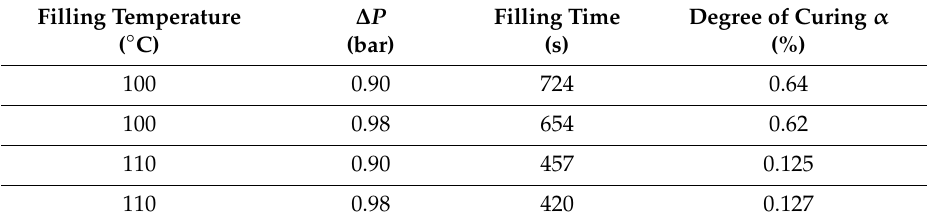
Table 4. E ff ect of the vacuum level, filling temperature, and vent configuration on the filling time. Filling Temperature ( ◦ C)